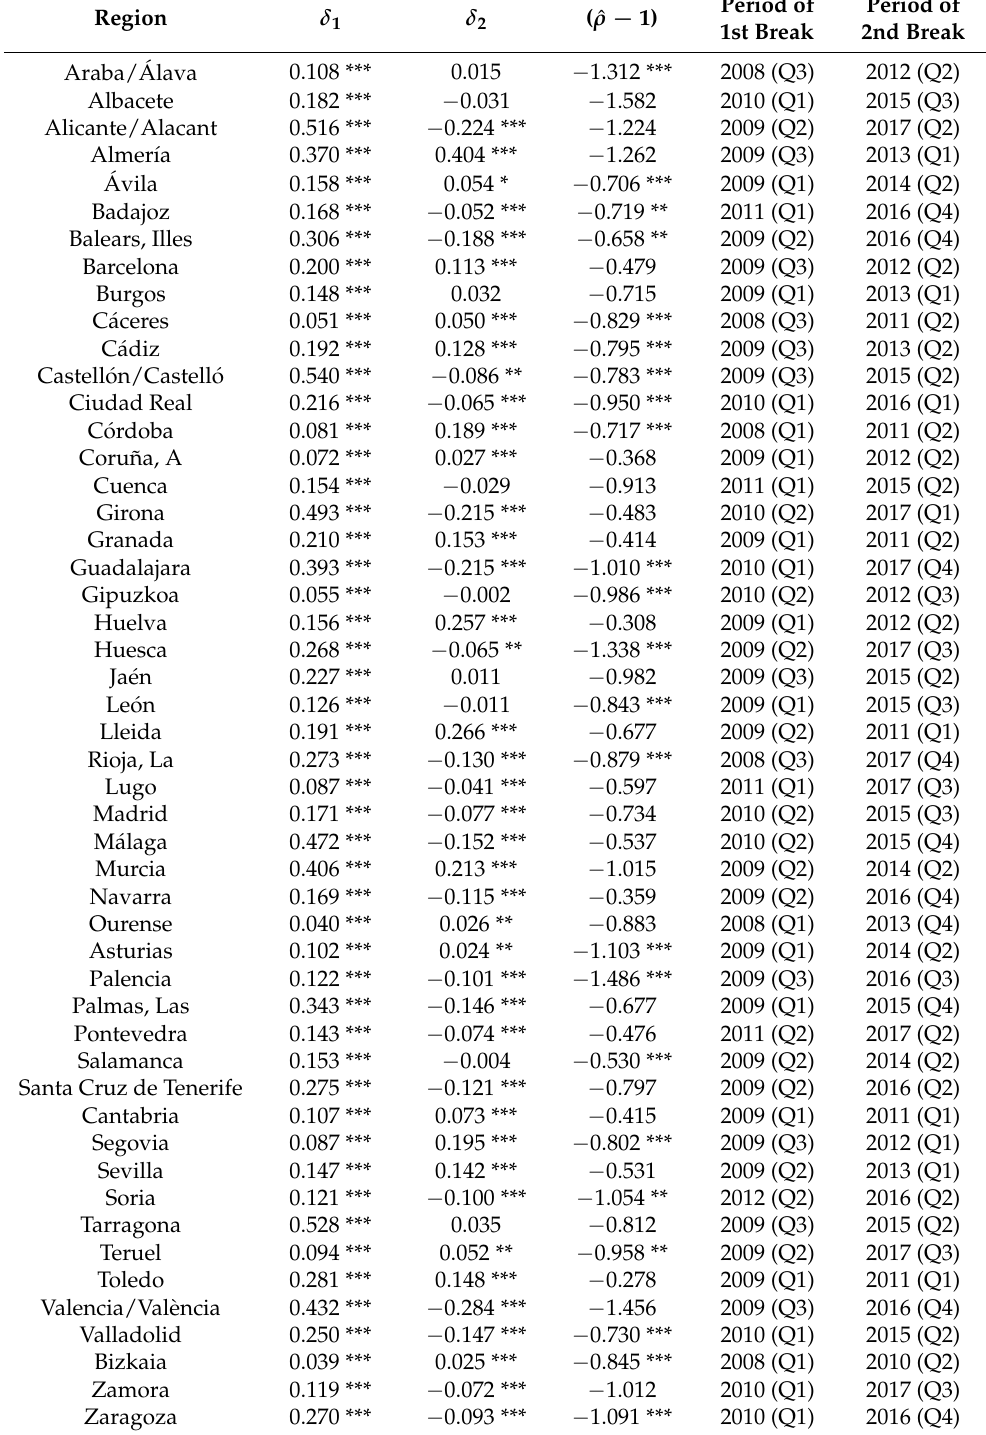
Table 4. Unit root tests on foreclosure rates, double structural break